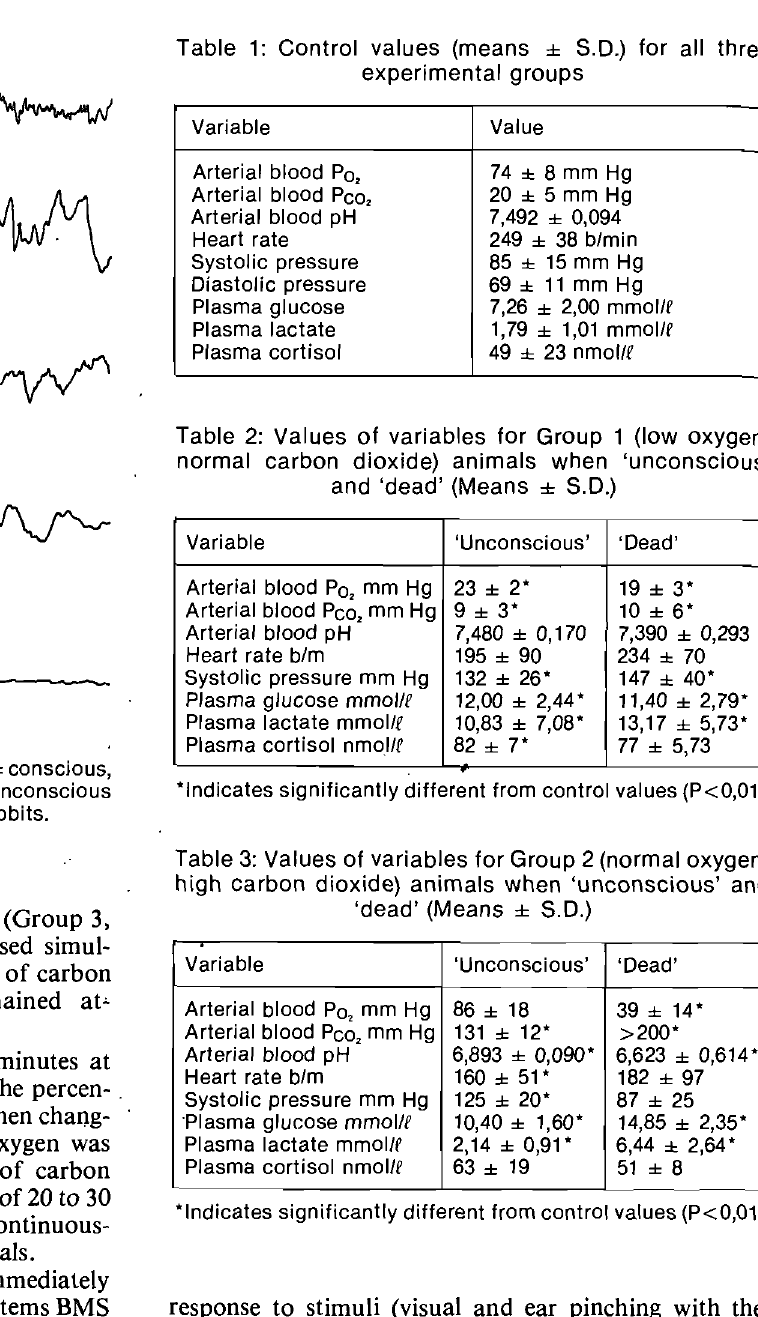
Table 1: Control values (means ± S,D.) for all three